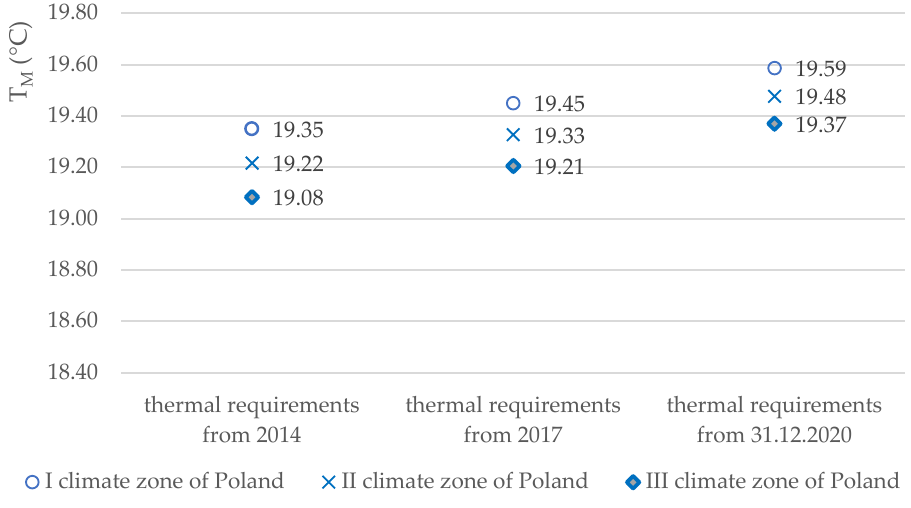
Figure 8. Changes in the perceptible temperature in the living room along with the change of the required thermal insulation of the external wall in different climatic zones of Poland (own elabora- tion).